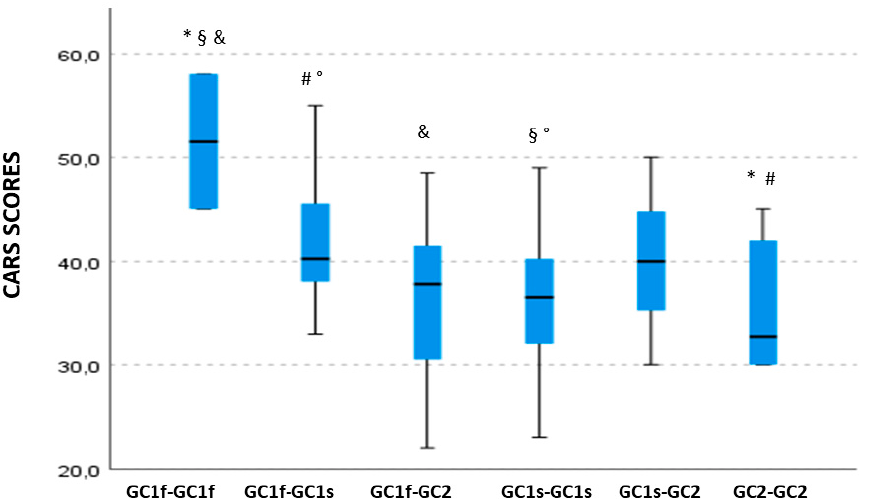
Figure 2. Boxplot of the distribution of CARS scores in relationship with the GC isoform phenotypes. Within each box black lines denote median values. Statistically significant pairwise comparisons are reported: *: p = 0.021 §: p = 0.024 &: p = 0.035 °: p = 0.018 and #: p = 0.049.